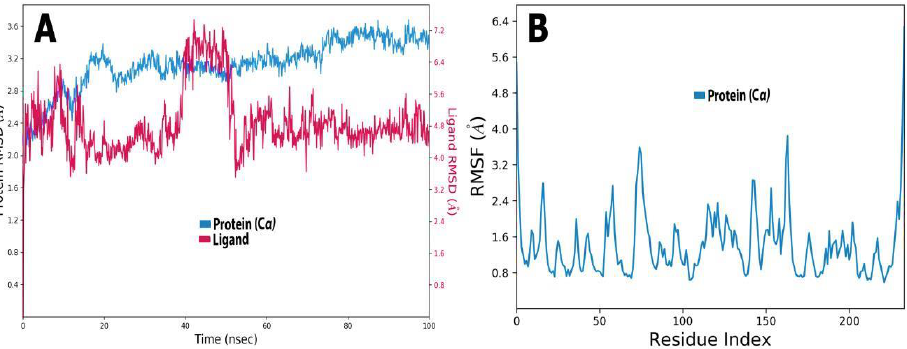
Figure 11. ( A ) RMSD plot obtained for oleuropein of the protein-ligand EFLec complexes. Protein Cα and compound RMSD are shown in blue and red colour, respectively. ( B ) RMSF plot of the protein’s backbone atoms during the 100 ns MD simulation . P rotein Cα RMSD is shown in blue. A study of the RMSF profile of the EFLec protein bound with oleuropein revealed fluctuations in the urease sequence. The RMSF profile for EFLec protein showed 1 – 2 nm